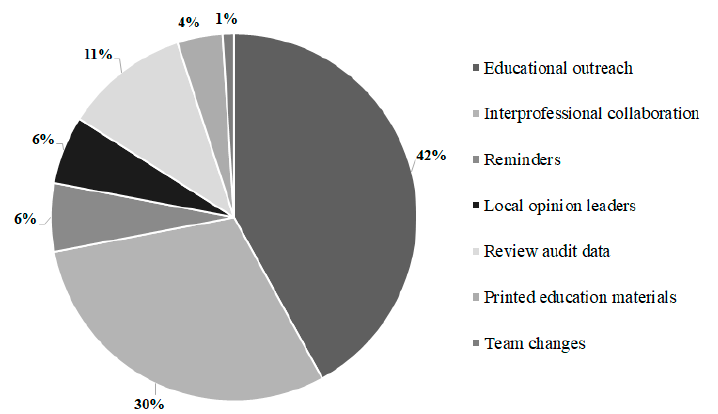
Figure 1. Proportion of professional behavior change interventions (categorized by the Cochrane Effective Practice and Organization of Care Group) [8] provided by the external facilitators.